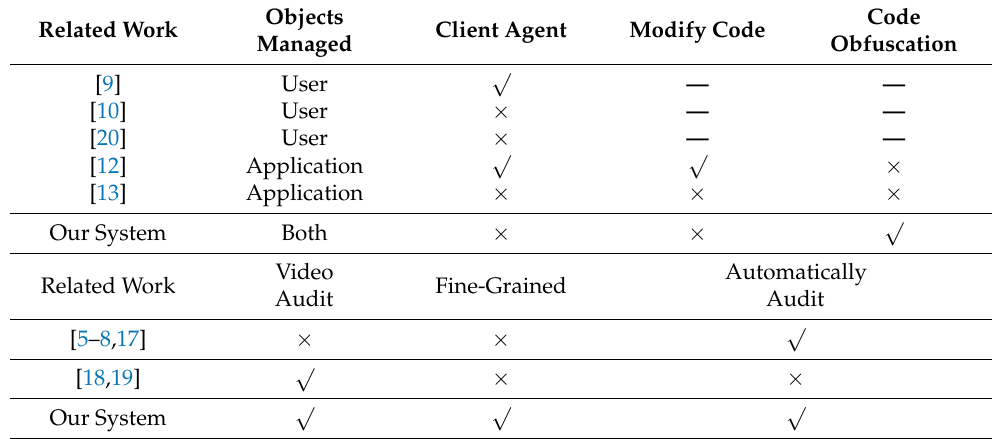
Table 1. Comparison of privileged account management and user behavior audit.